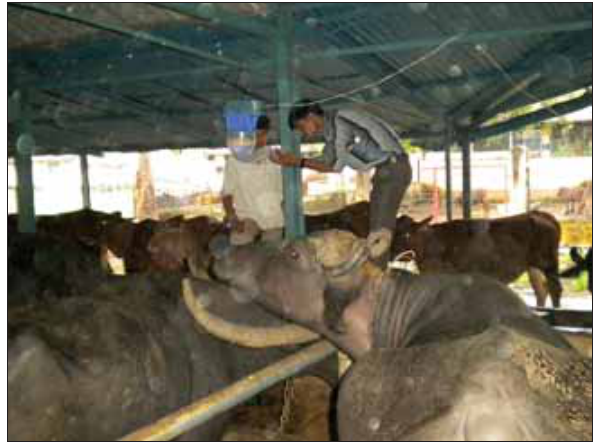
Figure-1: Light tap collections of Culicoides spp. and other flies in buffalo shed.